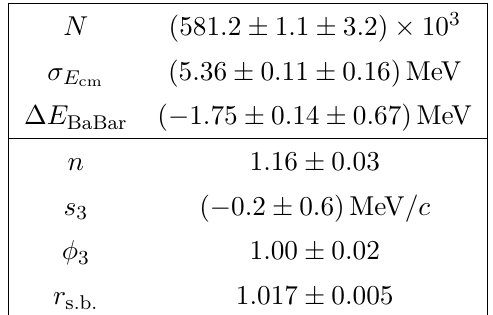
Figure 5 . Energy dependence of the total b ¯ b cross section ( R b ). Points with error bars are from ref. [1]. Black solid curve is the result of the simultaneous fit to this distribution and the M bc distributions (figure 4). Blue curve is the visible cross section before accounting for the E cm spread. Red curve is the dressed cross section. Vertical dashed lines indicate the B ¯ B threshold, the nominal Belle c.m. energy E cm0 , and the B ¯ B ∗ threshold, in increasing values of E cm .